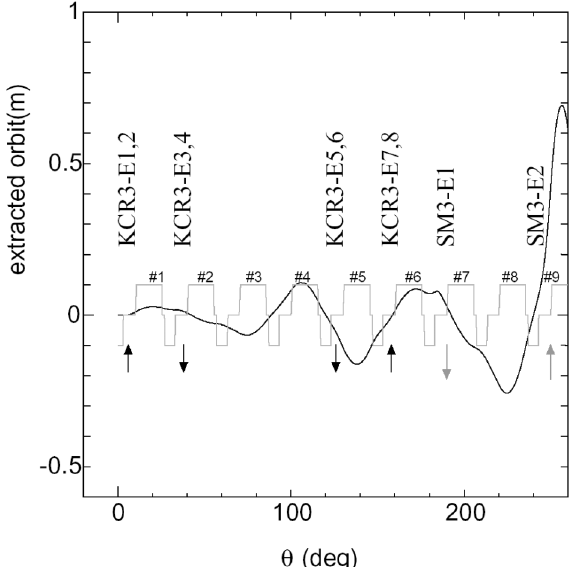
FIG. 13. Fast-extraction system estimated for tightly spaced lattice configuration of the HE-FFAG ring. Assuming brute- force extraction, at least eight kickers and two septum magnets are needed to obtain a beam separation of 420 mm.